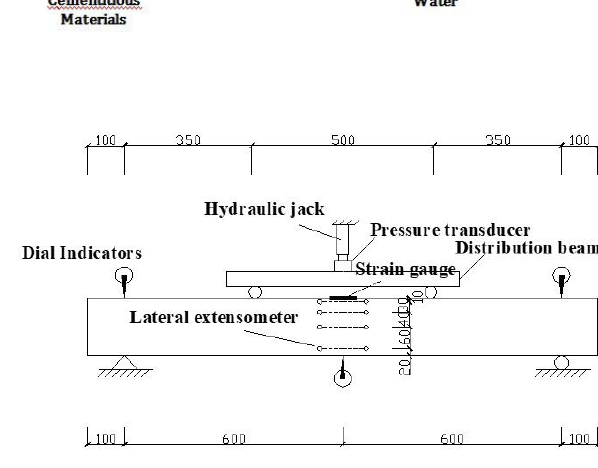
Figure 6: Experimental arrangement of stress and strain equipment in beam test